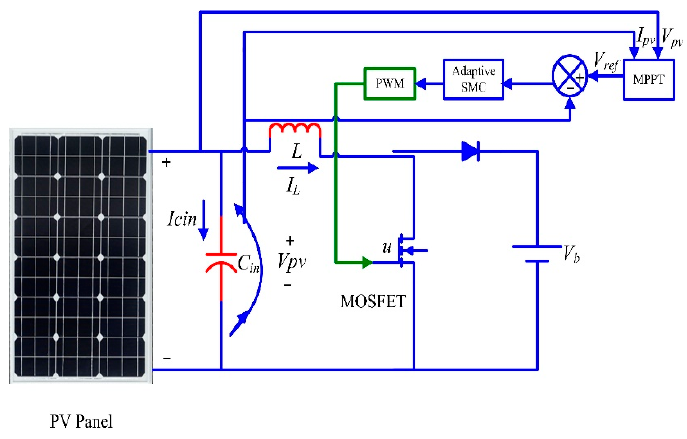
Figure 6. System circuital scheme based on Adaptive sliding mode control.